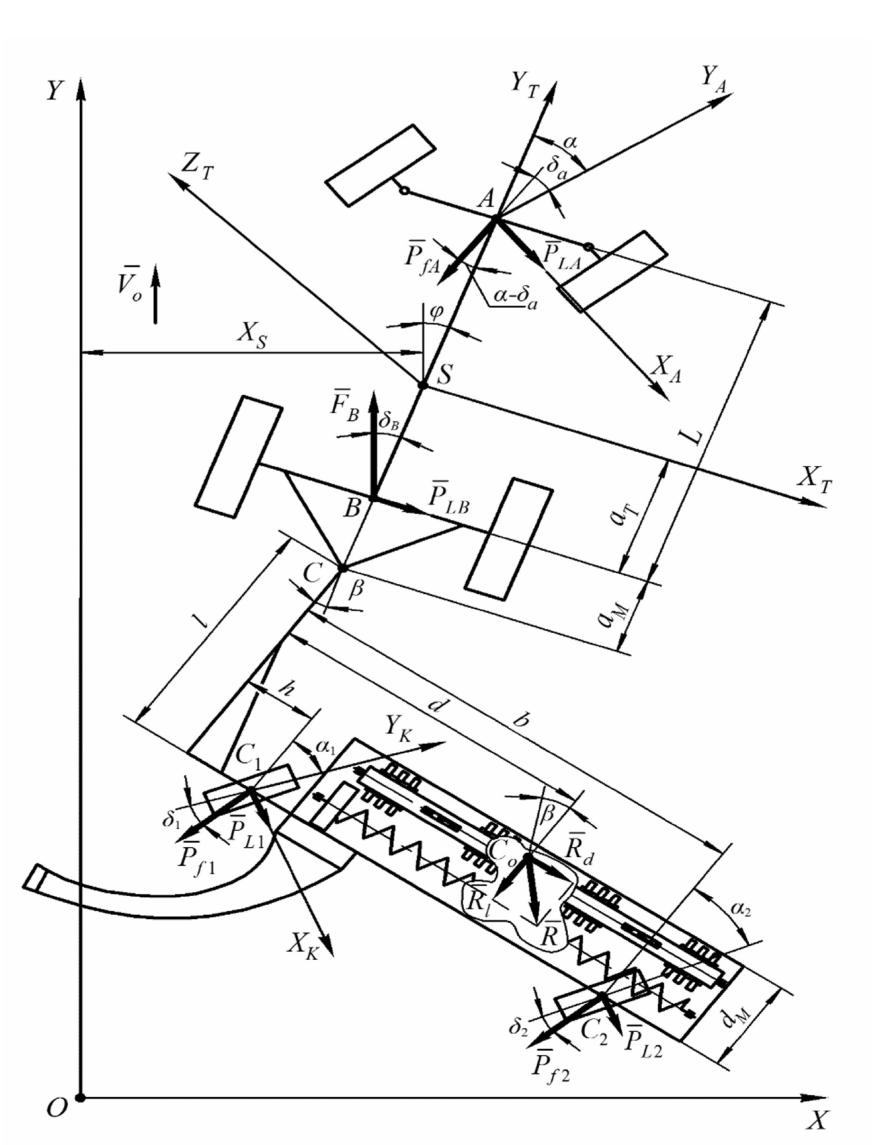
Figure 2. Equivalent scheme of asymmetric haulm harvester machine-tractor unit